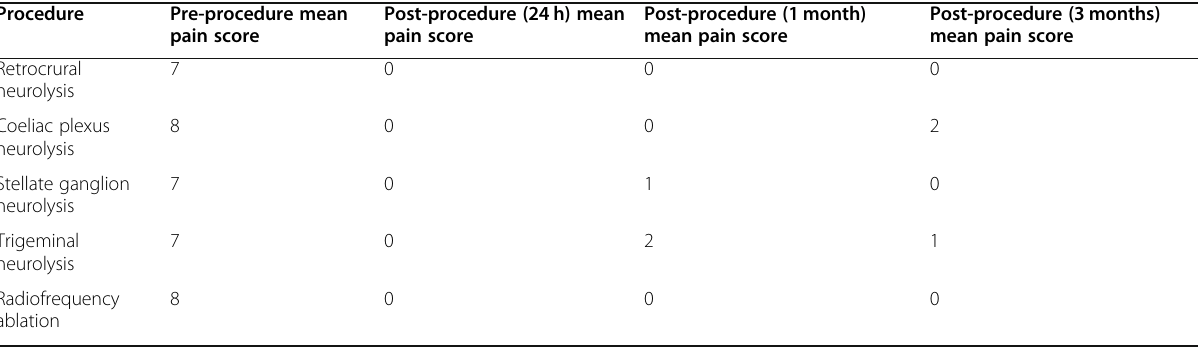
Table 3 The mean pain score before and after 24 h and 1 and 3 months post-procedure in each CT-guided pain management